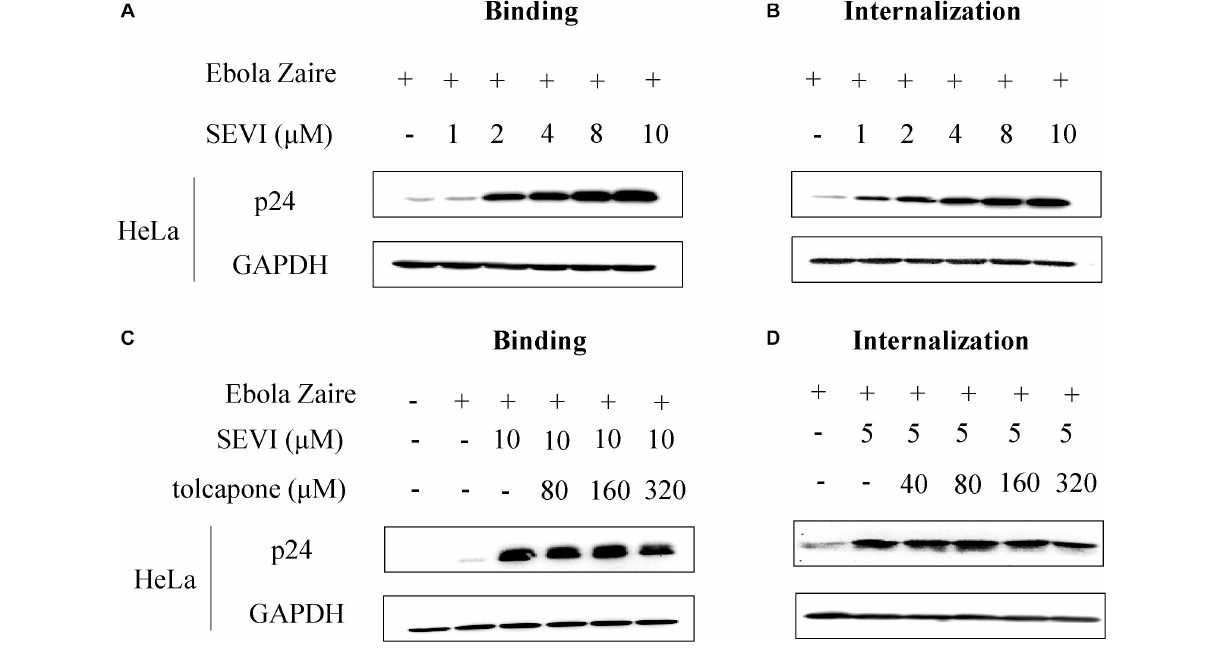
Frontiers in Microbiology |